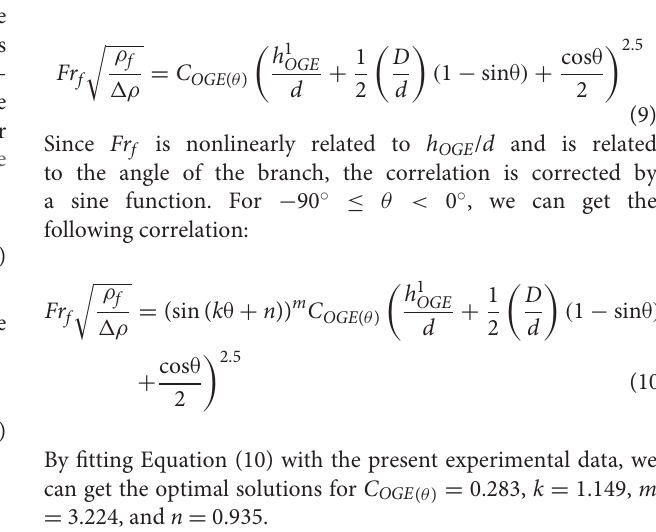
Frontiers in Energy Research |